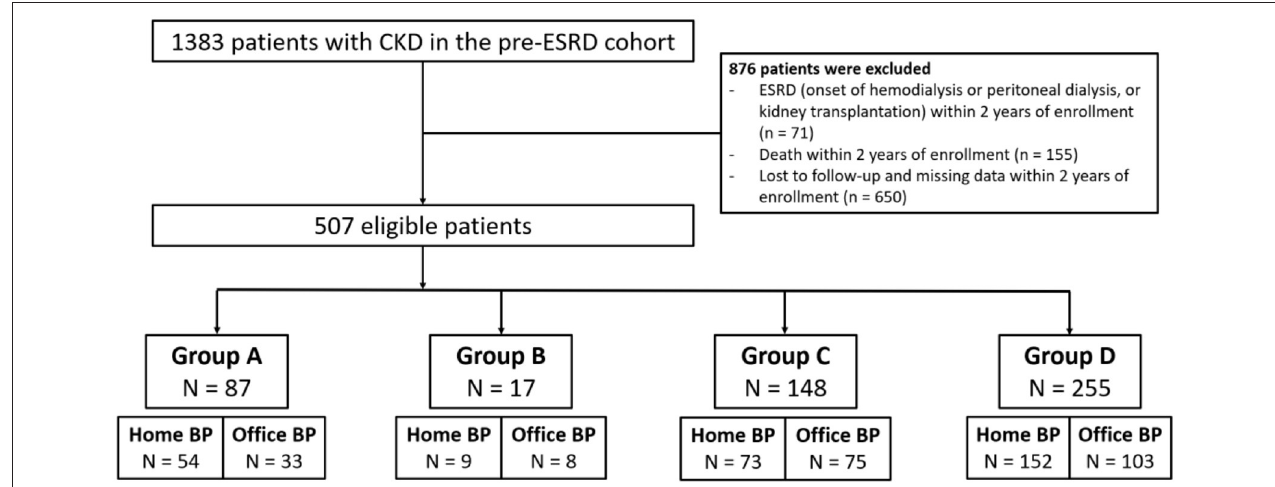
FIGURE 1 | Flow chart for patient selection. CKD, chronic kidney disease; ESRD, end stage renal disease; BP, blood pressure; group A, BP elevation in the wintertime; group B, BP reduction in the wintertime; group C, large variation of BP; group D, stable